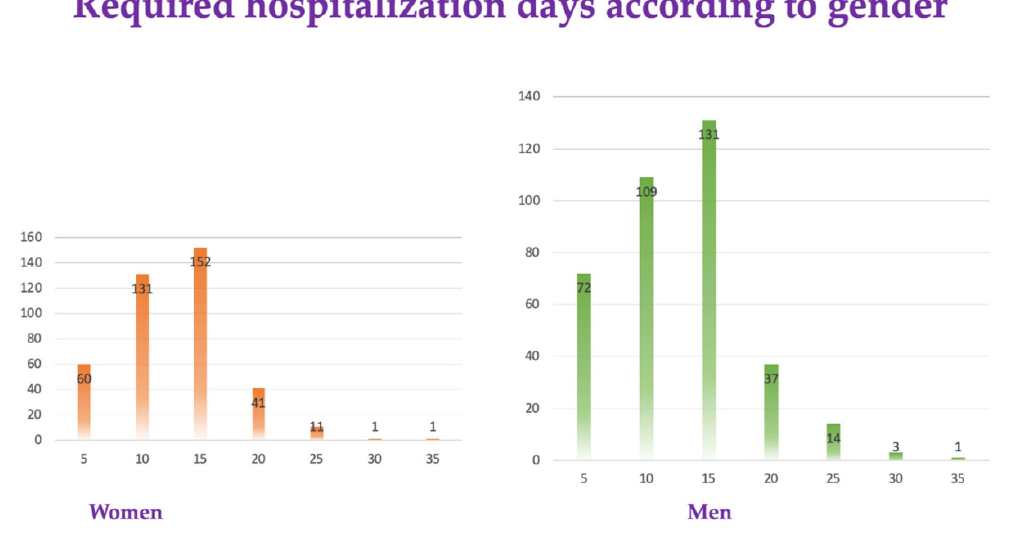
Figure 2. Required hospitalization days according to gender.